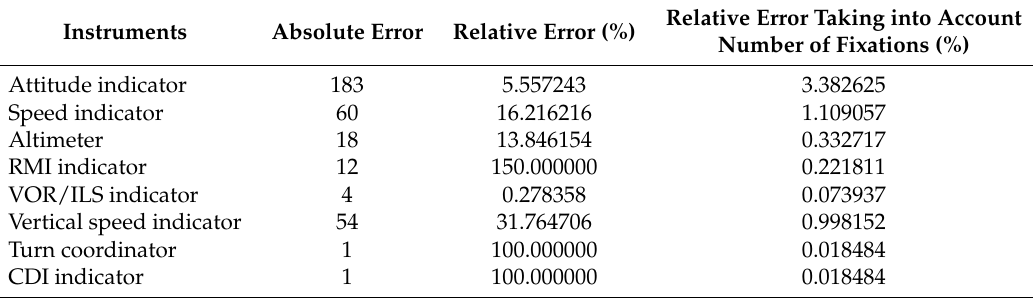
Table 4. Percentage contribution of individual instruments in the process of vision: VFR pilot.